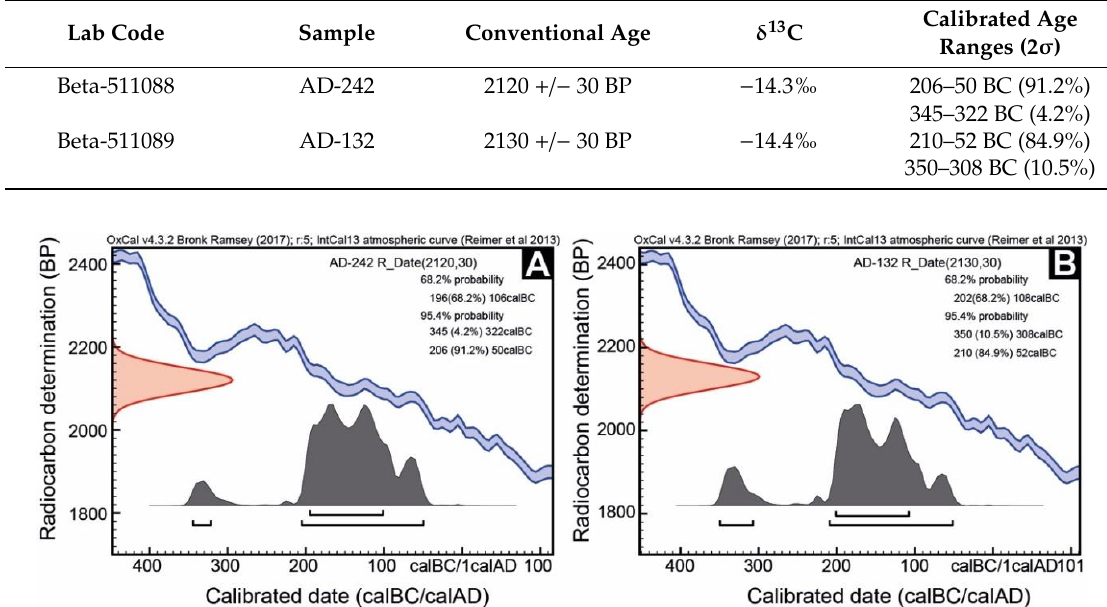
Table 4. Radiocarbon age determinations of the mortars from Arroyo de La Dehesa de Velasco.